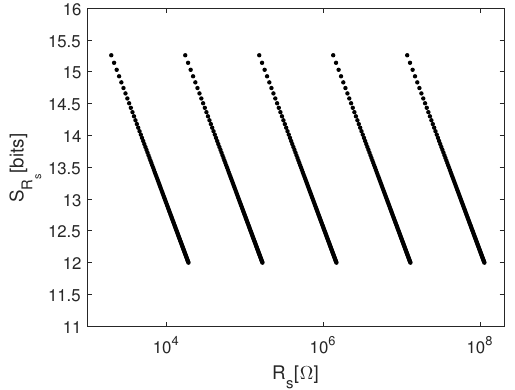
Figure 4. Resolution of the sensor resistance